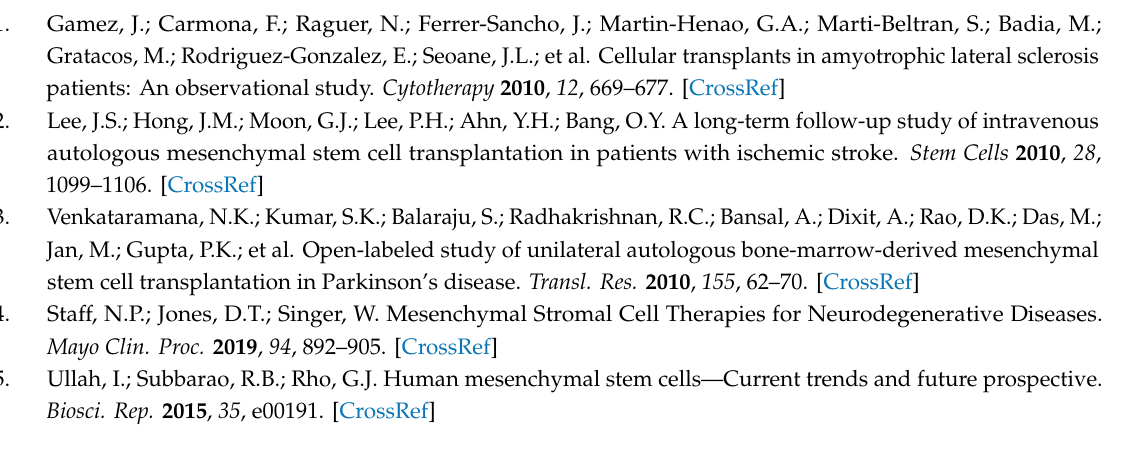
Figure S1: Characterization of MSCs derived from bone marrow. ( A ) Multilineage di ff erentiation capacity of MSCs. MSCs were cultured into 24-well plates and stimulated to di ff erentiate along adipogenic, osteogenic, and chondrogenic lineages using an MSC functional identification kit (R&D Systems, Minneapolis, MN, USA). After di ff erentiation, lipid droplets in adipocytes were visualized with oil red O staining (Sigma, Saint Louis, MO, USA). Osteogenic di ff erentiation was assessed based on the staining of calcium deposits by alizarin red (Sigma, Saint Louis, MO, USA), and chondrogenic di ff erentiation was determined by alcian blue staining (Sigma, Saint Louis, MO, USA). ( B ) Immunophenotypic analysis for expression profiles of cell surface markers of MSCs in the early phases. To confirm the MSC characteristics, cells within five passages were stained with the cell surface markers CD29, CD73, CD90, CD105, CD34, CD45 (BD Pharmingen, Heidelberg, Germany), and CD44 (BD Biosciences, San Diego, CA). The expression of cell surface markers was measured using a flow cytometer (BD FACS Canto ™ II), and MSCs were identified as CD29 / CD44 / CD73 / CD105-positive and CD34 / CD45-negative cells; Figure S2: Characteristics of the immune modulatory potential of mesenchymal stem cells (MSCs) derived from cerebellar ataxia patients (CA-MSCs) with regard to astrocytes activation. ( A ) Schematic drawing of the experimental procedure. The conditioned medium obtained from MSCs culture was added with / without lipopolysaccharide (LPS) (100 ng / mL) to primary astrocytes for 24 h. ( B ) Nitric oxide assay in primary astrocyte culture. Nitric oxide production was measured using Griess solution and was used as an indicator of glial activation. Data are presented as mean ± SEM. One-way analysis of variance was followed by the Tukey posthoc test. *** p < 0.001 vs. control; ## p < 0.01, ### p < 0.001 vs. control + LPS; †† p < 0.01 vs. healthy-MSC-CM + LPS; Figure S3: The p -value heat map of significant biological processes within either the secretome of MSCs derived from healthy individuals (H-MSCs) or MSCs derived from CA-MSCs. The heat map is colored by the significance (log p -value) of enrichment of the biological process, where a darker red indicates a higher degree of enrichment and darker green indicates a higher degree of deficiency of functional activities. Ontological analysis was performed using the Database for Annotation, Visualization, and Integrated Discovery (DAVID, version 6.8); Table S1: List